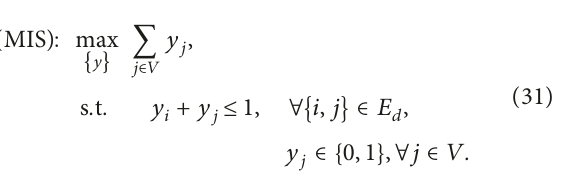
Table 4: Numerical results for P